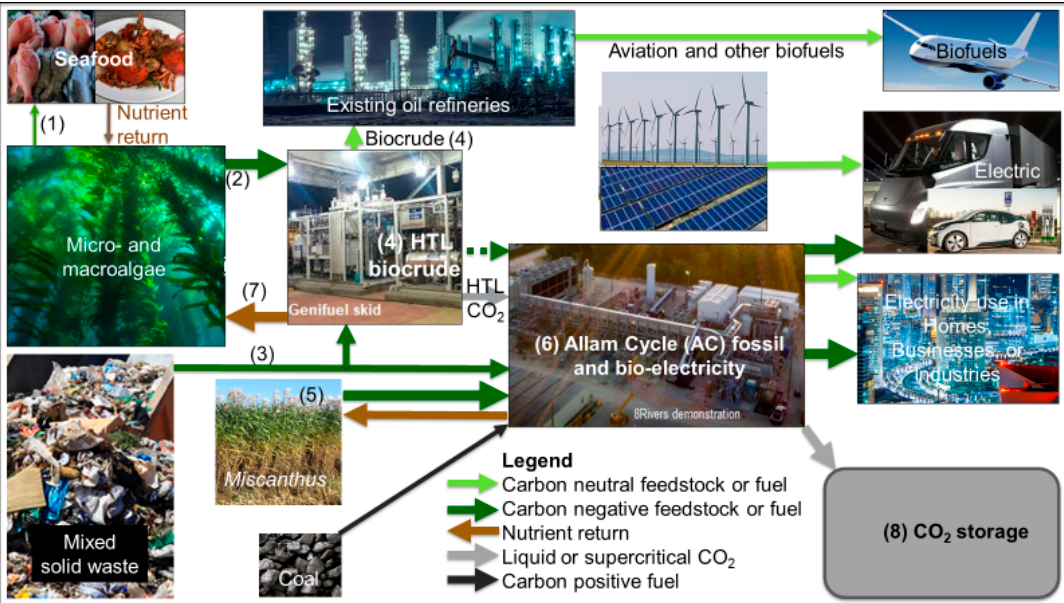
Figure 3. Process overview for mature (2070 and beyond) production of food, energy, and CO 2 sequestration. It is a simplified representation of the future global energy system with future oceanic integrated food and energy systems. It does not show terrestrial food systems. Each country and community will determine how much of each component is appropriate depending on local economics. (Note: Miscanthus represents all terrestrial biomass including wood waste, agricultural residues, etc. that might be gasified directly at the Allam Cycle electricity facility or fed to HTL. Solid waste represents organic sludges, food waste, paper, and plastics that are not recycled some other way. Micro- and macroalgae represent all watery biomass including seagrass and freshwater plants. The darker green and thicker arrows are paths to more bio-CO 2 storage (CO 2 removed from the environment, i.e., negative emissions). The lighter green and thinner arrows lead to carbon-neutral emissions, including bio-CO 2 emissions from combustion by airplanes, or wind and solar power.